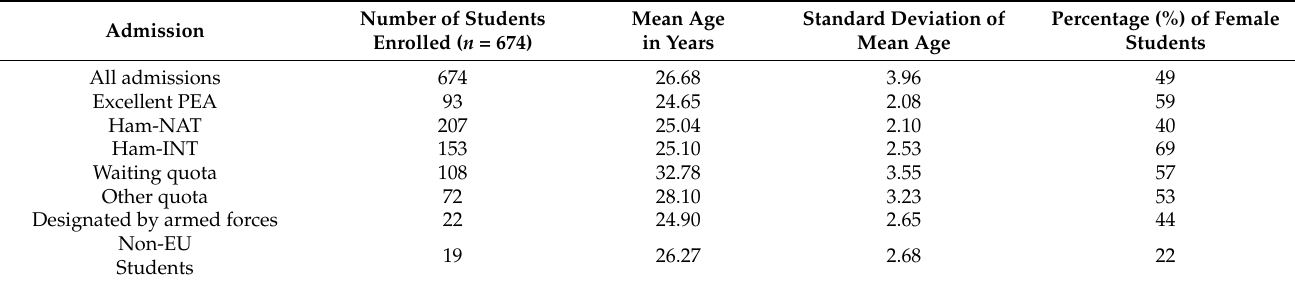
Table 1. Demographic data of study